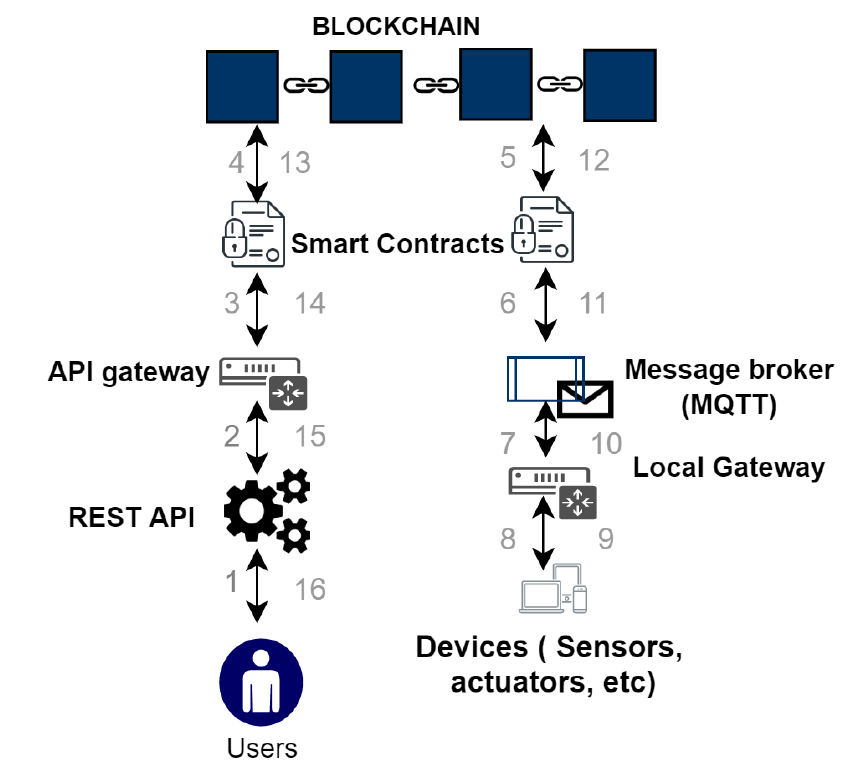
Figure 3. Transaction execution